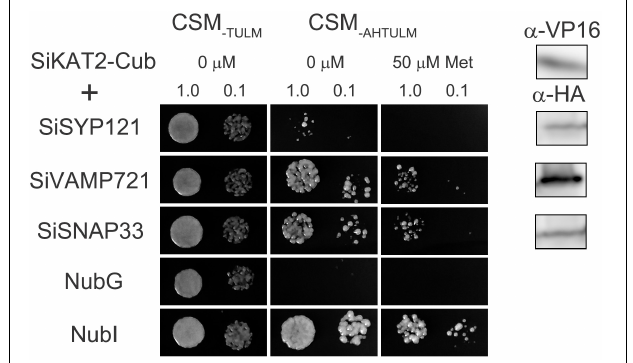
FIGURE 7 | SiKAT2 selective interact with SiSNARE proteins. Yeast mating-based split-ubiquitin assay for the interaction of SiSYP121, SiVAMP721, and SiSNAP33 with SiKAT2-Cub as baits. After several attempts, SiKAT3 failed to transform into yeast. Yeast diploids were created with NubG fusion constructs of each of the SiSNARE proteins together with controls (NubG, negative; NubI, positive) spotted (left to right) on CSM medium without Leu, Trp, Ura, and Met (CSM - TULM ) to verify mating, CSM medium without Leu, Trp, Ura, Met, Ade, and His (CSM - AHTULM ) to verify adenine- and His-independent growth, and on CSM - LTUMAH with the addition of Met to verify interaction at lower K + channel-Cub expression levels. Diploid yeast was dropped at 1.0 and 0.1 OD600 in each case. Immunoblot analysis (5 µ g total protein/lane) of the haploid yeast used for mating (right) using commercial α -HA antibody for the SiSNARE fusions and α -VP16 antibody for the K + channel